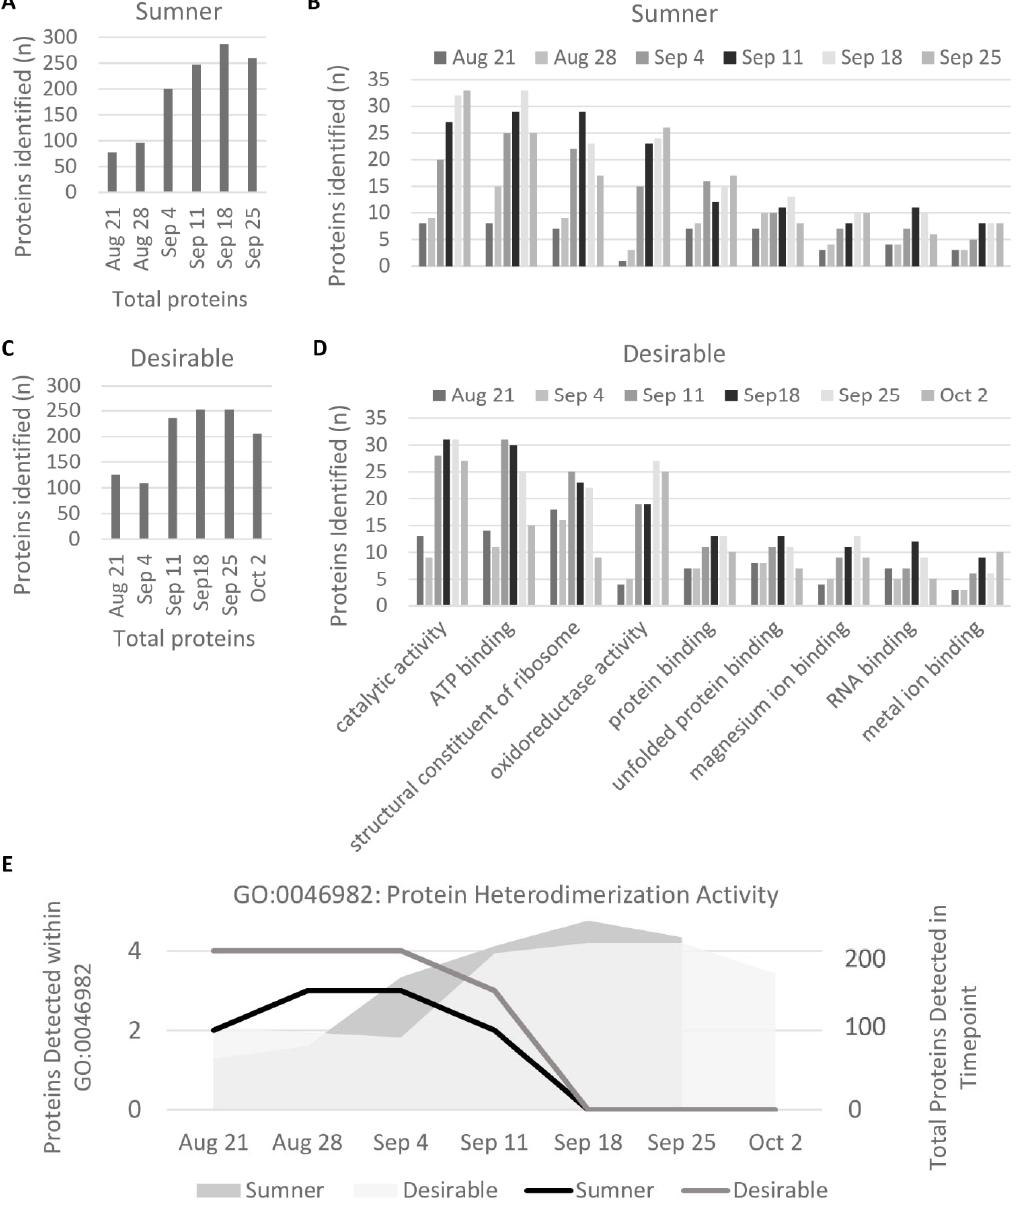
Figure 4. Molecular Function GO Terms. ( A , C ) Protein diversity by developmental time point. ( B , D ) GO Terms within which at least ten proteins were detected at any stage and either cultivar. ( E ) GO Term for which the number of proteins detected decreased significantly during development (GO:0046982), plotted in black and gray. Gray shading shows total number of unique proteins detected in sample annotated by the y ‐ axis on the right side of the graph.